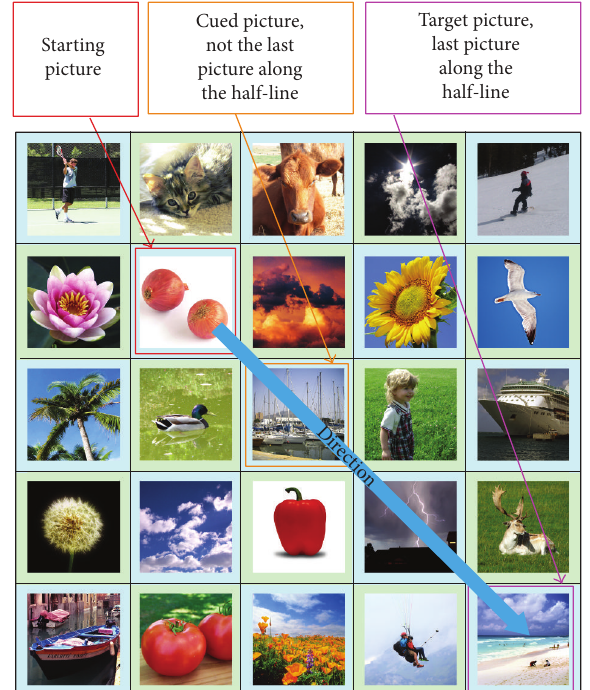
Figure 8: Scenario 2: cued picture on the half-line and not the last